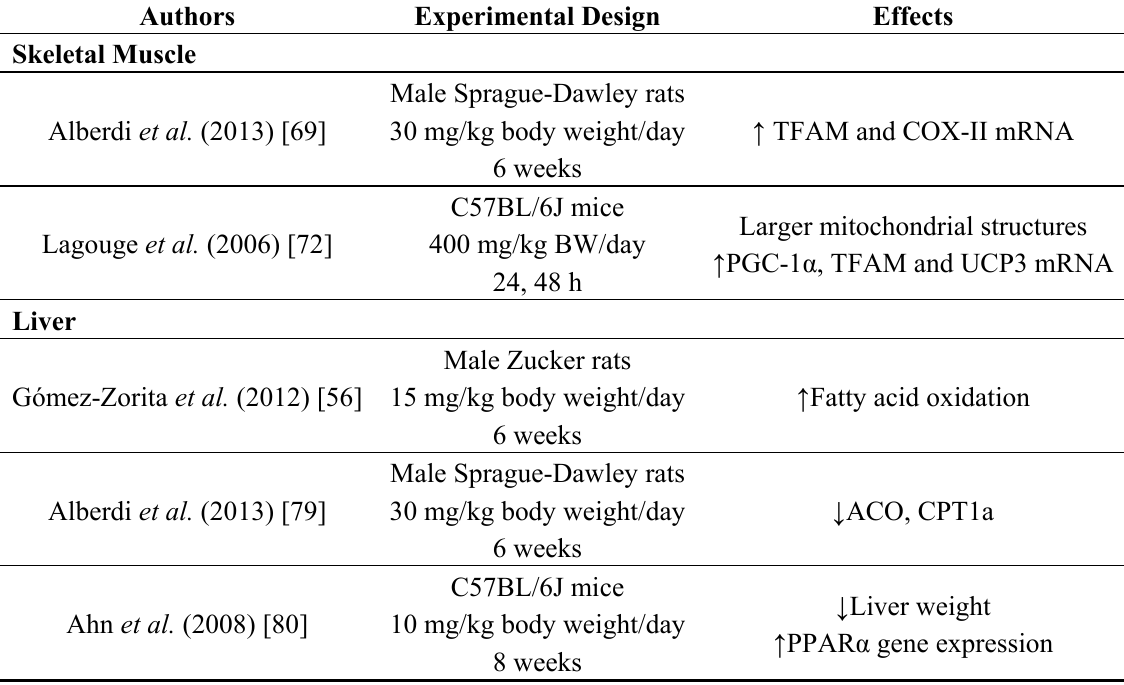
Table 6. Effects of resveratrol on lipid oxidation in in vivo